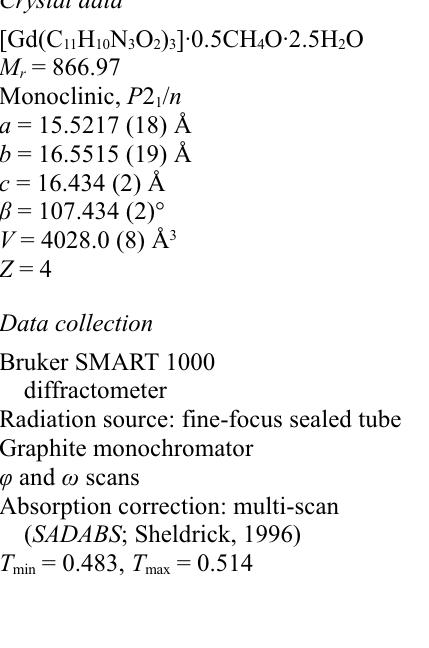
Crystal packing as viewed down the c-direction showing the hydrogen bonded interactions as dashed lines. Tris[6-(3,5-dimethyl-1 H -pyrazol-1-yl)picolinato]gadolinium(III) methanol hemisolvate 2.5-hydrate Crystal